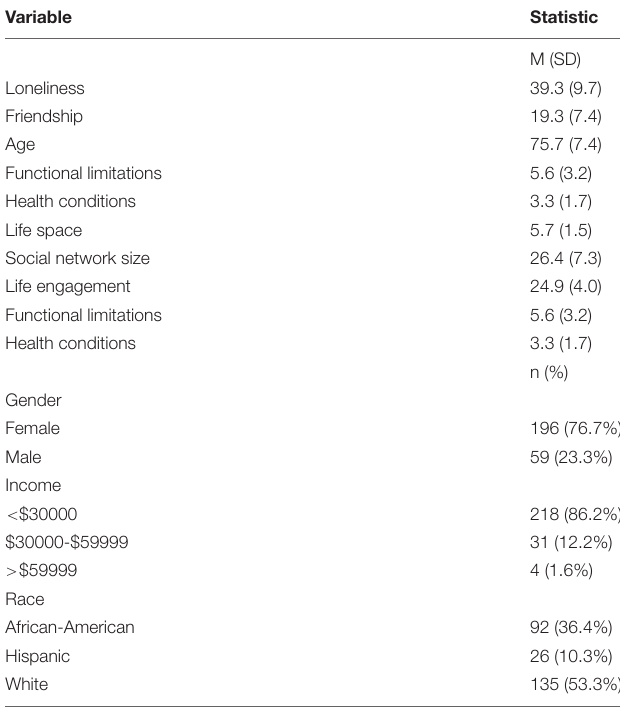
TABLE 6 | Descriptive statistics for hierarchical variables included in the multiple regression analyses ( N =